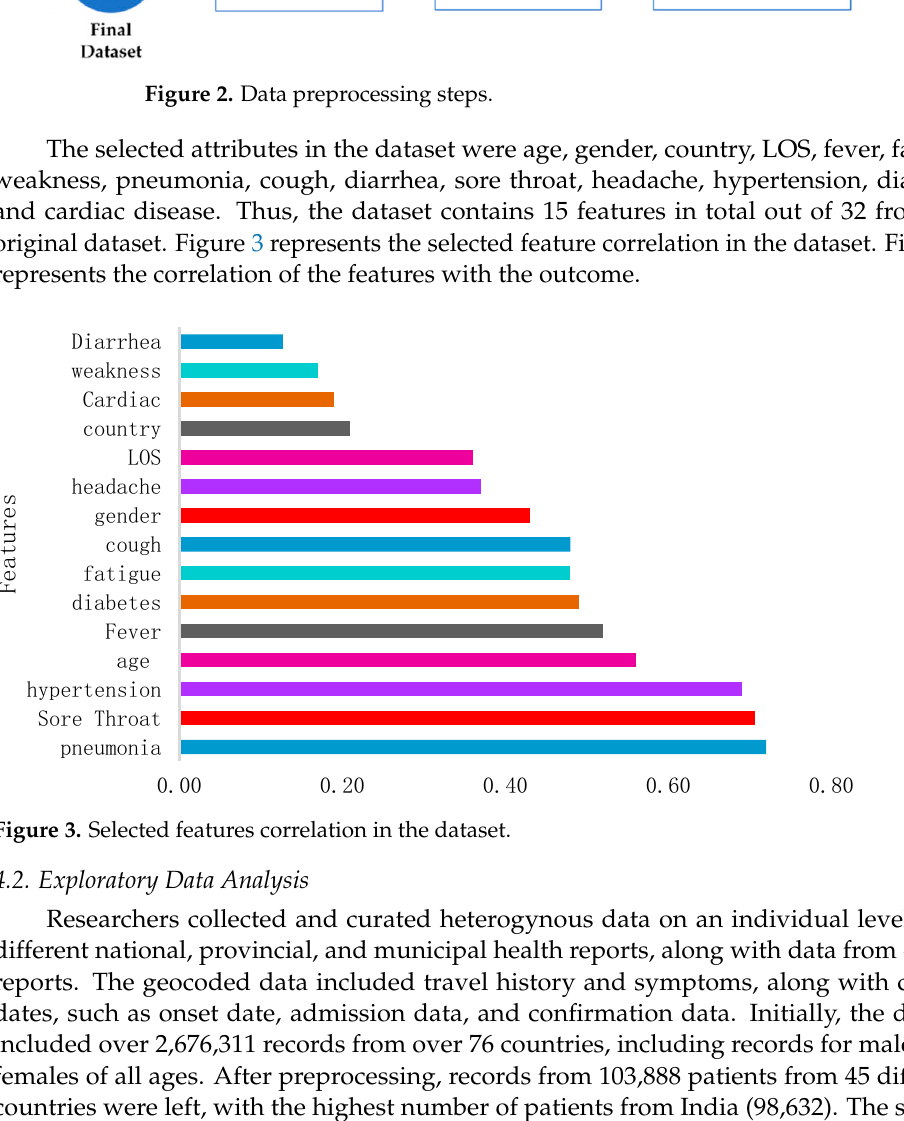
Figure 3. Selected features correlation in the dataset.